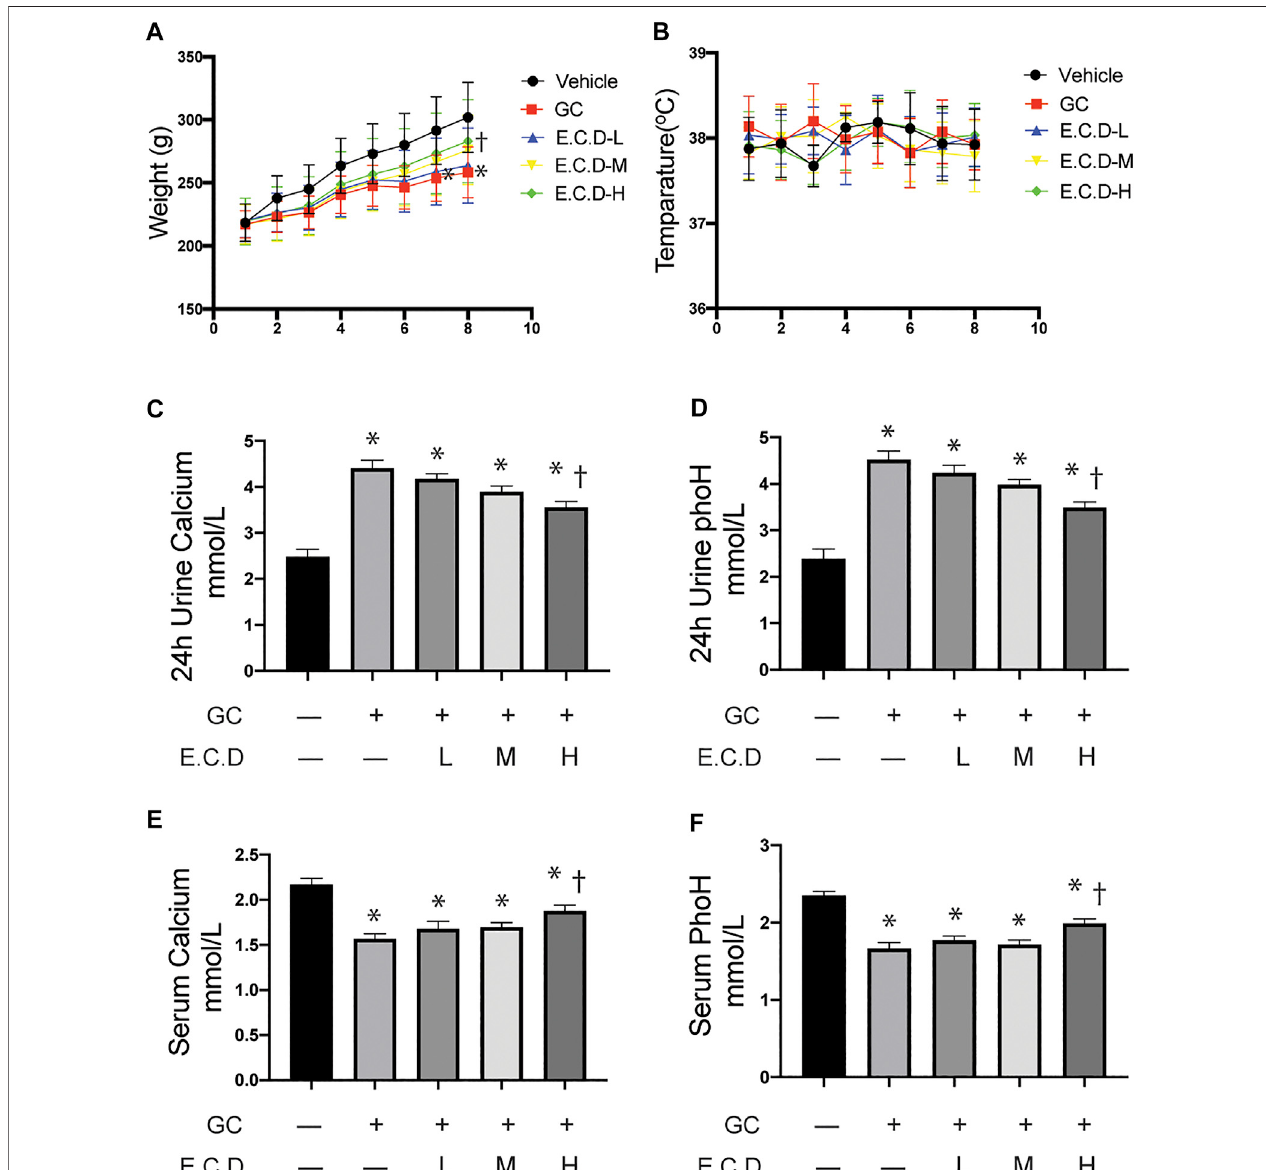
FIGURE1| E.C.D.extractsprotectedbodyweightloss,andcalciumandphosphoruslossofGIOrats. (A) Ratswererandomlydividedinto fi vegroup, n =8ineach group: Vehicle group(black,dot),GCgroup (red,square),E.C.D.-Lgroup(blue,triangle),E.C.D.-Mgroup(yellow, down triangle), E.C.D.-H group (green,diamond).The change of body weightfrom Week 0 to Week 8 was recorded. * GC group vs. Vehicle group, † E.C.D.-H group vs. GC group, p < 0.05. (B) The temperature of rats was recorded every week (0-8) with no signi fi cant difference between each group. (C,D) The 24-h urine calcium and phosphorus (phoH) were collected 8 weeks after GCadministration, n =8ineachgroup. (E,F) Theserumcalciumandphosphorus(phoH)weremeasured8 weeksafterGCadministration, n =8ineachgroup.Datawas analyzed as mean ± SEM, * vs. Vehicle group (GC – E.C.D. – ), † vs. GC group (GC + E.C.D. – ), p < 0.05.